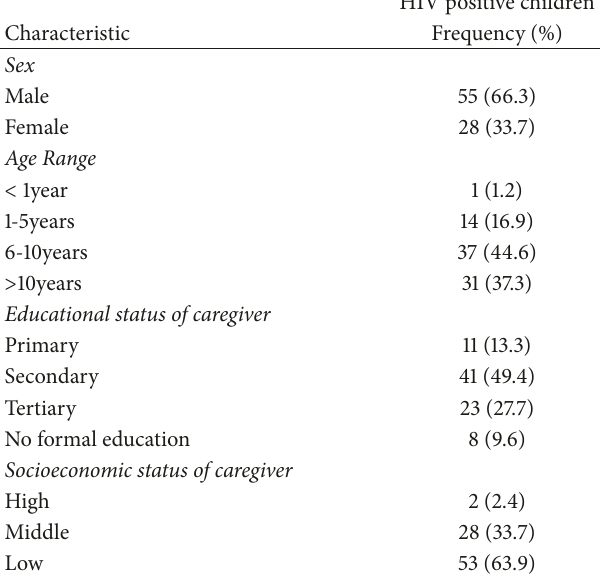
Table 1: Characteristics of children living with HIV.